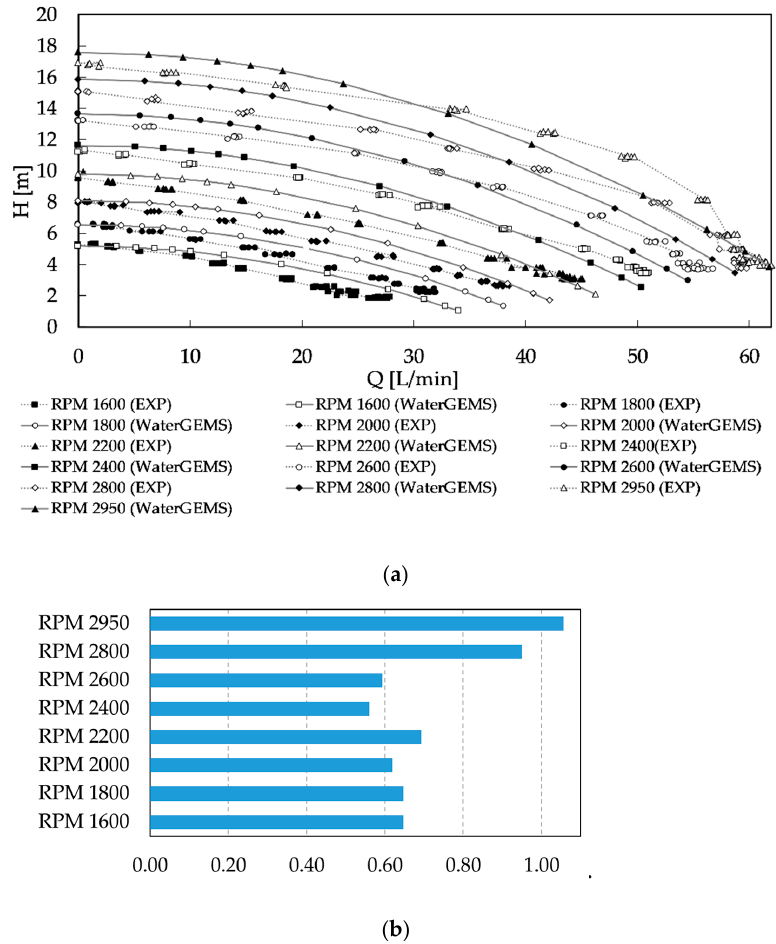
Figure 9. Comparison of experimental and numerical results for the BPS; ( a ) head and flow rate; ( b ) root mean square error (RMSE).